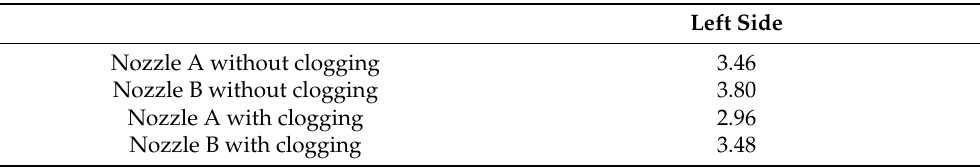
Table 3. Time spent by the discharging jets of nozzles A and B for the contact of the upper roll with the nozzle outer